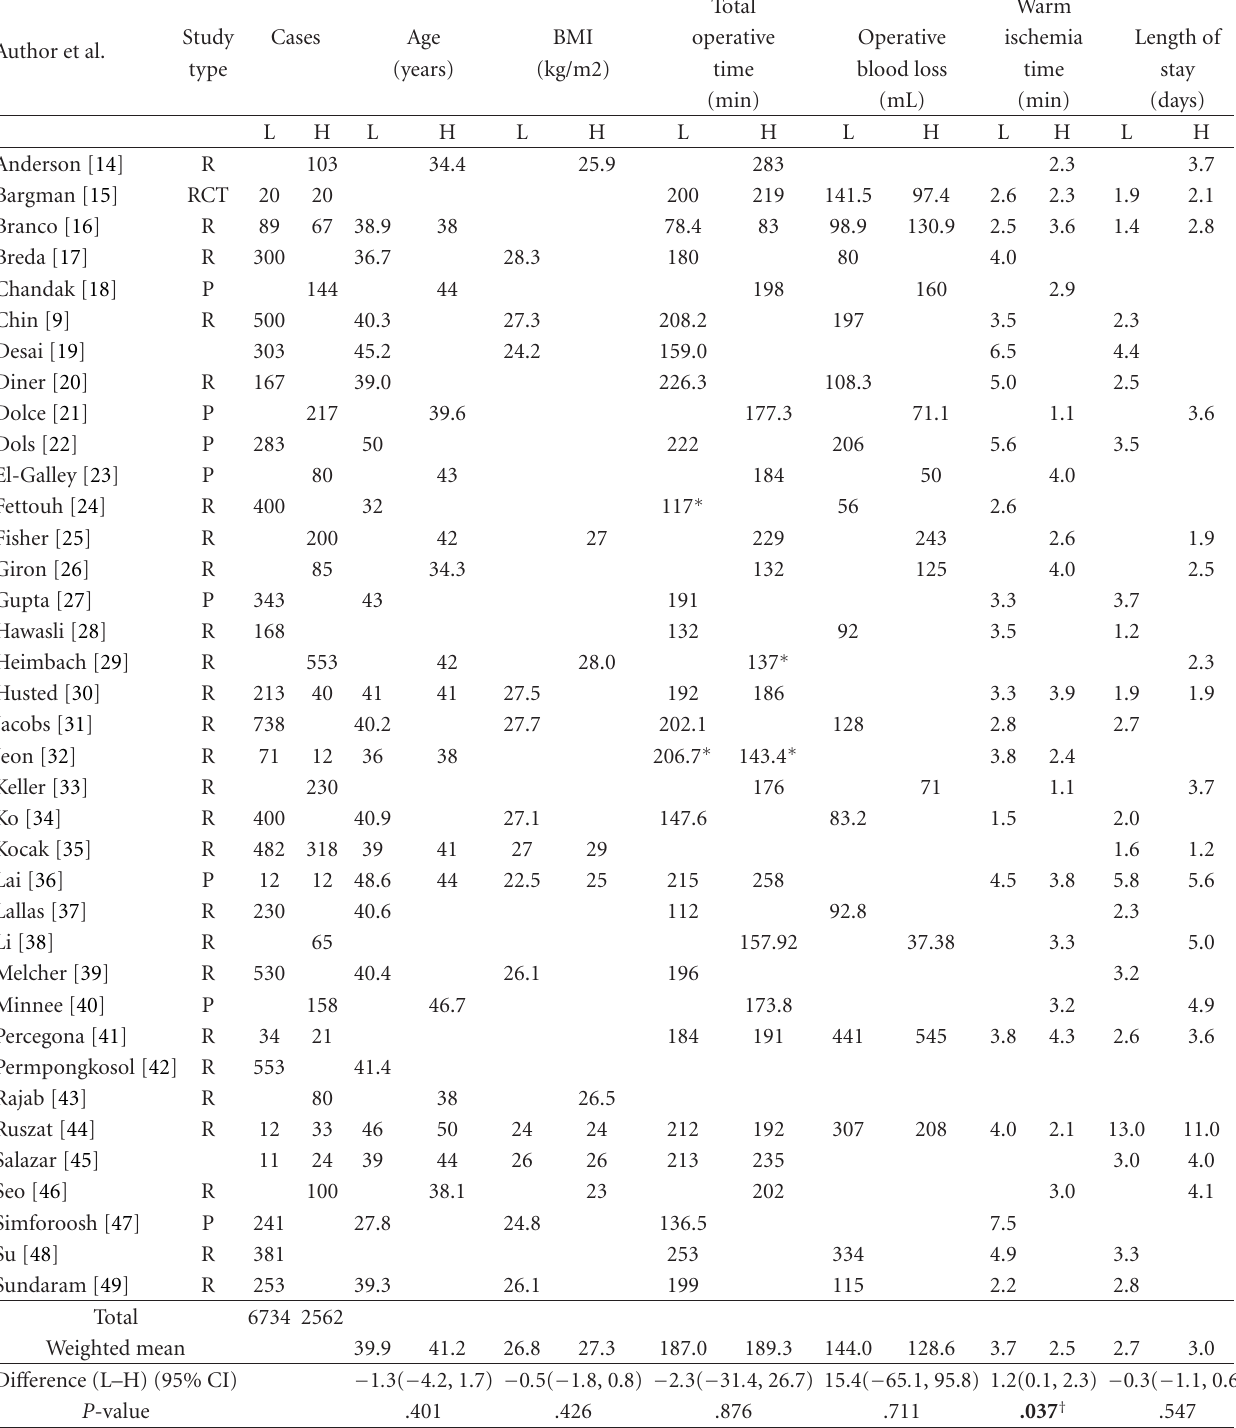
Table 1: Study characteristics, donor demographics and intraoperative